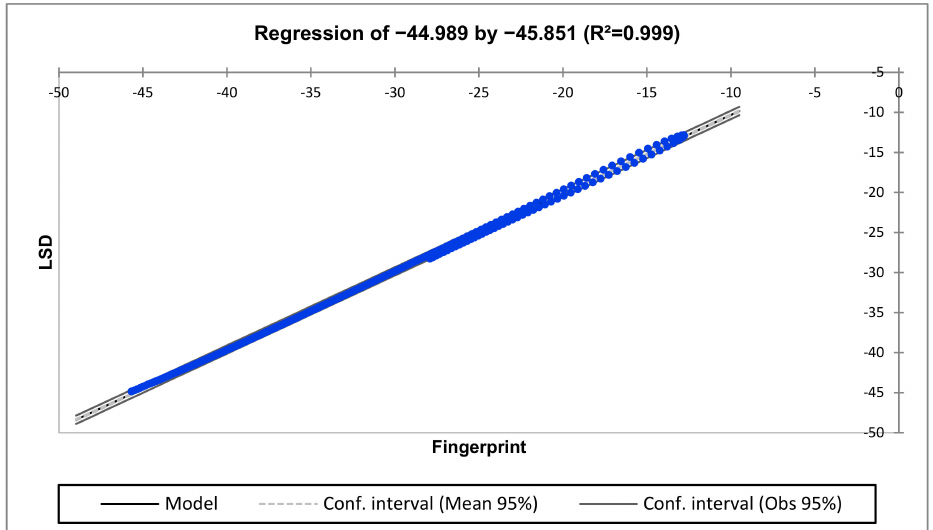
Figure 21. Regression for H2-H1 vs. H3-H2 (lower-frequency region).